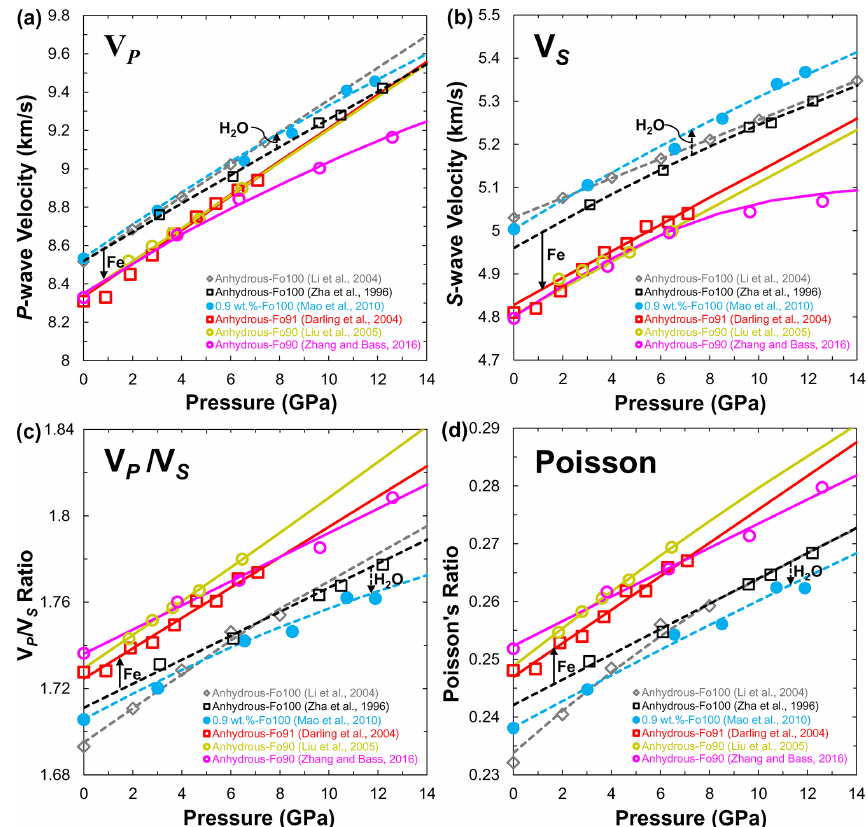
Figure 10. (a) Compressional ( V P ) and (b) shear wave ( V S ) velocities, (c) V P /V S ratio and (d) Poisson’s ratio of olivine at 300K as a function of pressure. Data sources: anhydrous olivine (single crystal: Zha et al., 1996; Zhang and Bass, 2016; polycrystal: Li et al., 2004; Darling et al., 2004; Liu et al., 2005); hydrous olivine single crystal (Mao et al., 2010). Closed and open symbols denote the experimental data, solid and dashed lines stand for the calculated results from third-order finite strain